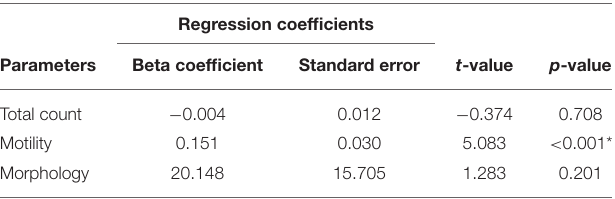
TABLE 3 | Regression analysis showing relationship of Vitamin D (25OHD) with sperm parameters in the study